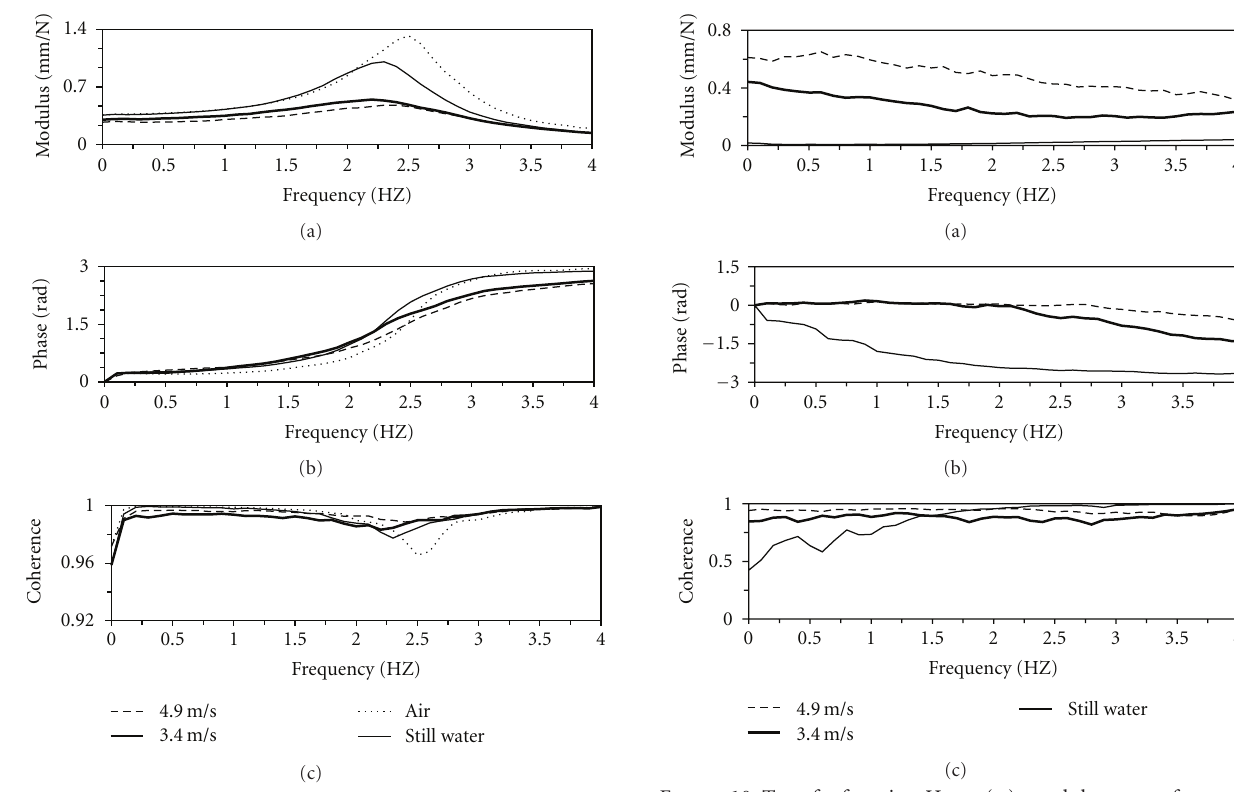
Figure 9: Transfer function H central ( ω ); modulus versus frequency (a), phase versus frequency (b); coherence between f central and u central versus frequency (c); in-air, in still water, and for 3.4m/s and 4.9 m/s fluid velocities.